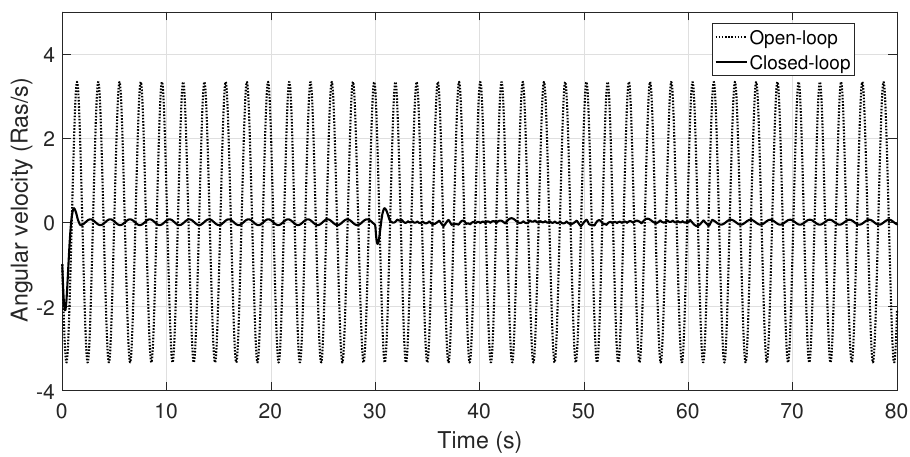
Figure 4. Numerical experiments: Angular velocity response.